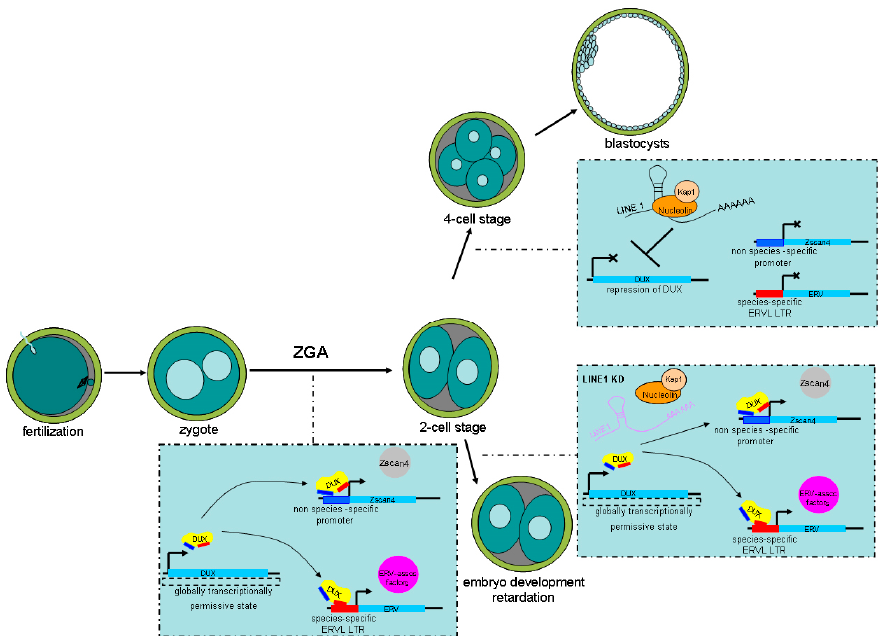
Figure 4. Schematic illustration showing how endogenous retrovirus (ERVs) activation is controlled by double homeobox DUX during murine pre-implantation development. After fertilization, a globally transcriptionally permissive state caused by the loosening of chromatin activates DUX. Then, DUX